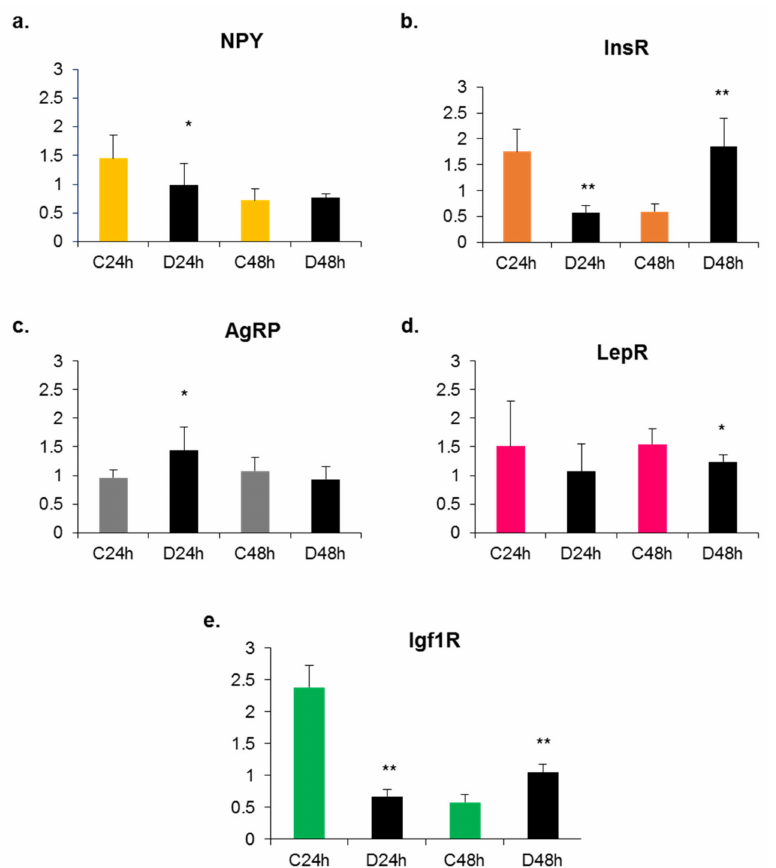
Figure 1. E ff ects of methyl donor deficiency on mRNA expression of neuropeptides and receptors in the mouse cell line (mHypoE46) at 24 and 48 h of growth. Data are means ± SD from 6 ≤ n ≤ 8 samples and are reported in arbitrary units. Statistically significant di ff erences between control (C) and B9 deficient (D) cells: * p < 0.05 and ** p < 0.01. ( a ) Neuropeptide Y (NPY); ( b ) Insulin receptor (InsR); ( c ) Agouti-related protein (AgRP); ( d ) Leptin receptor (LepR); ( e ) Insulin growth factor receptor 1 (Igf1R). RT-qPCR experiments led to two striking observations: the expression patterns of neuropeptides and receptors di ff ered between the two cell lines on the one hand, and on the other, they varied as a function of time in a given cell line. We observed that the rat cell line is a hypothalamic cell line secreting ghrelin and expressing receptors for NPY, insulin and leptin whereas the mouse cell line is an NPY / AgRP-secreting cell line. After 24 h of B9 deficiency, the expression of the AgRP gene was increased in the mouse cell line while the expression of NPY and of the various receptors was decreased. In the rat cell line, a 24 h B9 deficiency induced an overexpression of the genes encoding ghrelin and the di ff erent receptors. These results reflect the direct e ff ect of B9 deficiency on hypothalamic neuropeptides and receptors’ gene expression and show that receptor expression varied depending on the neuropeptide secretion by the